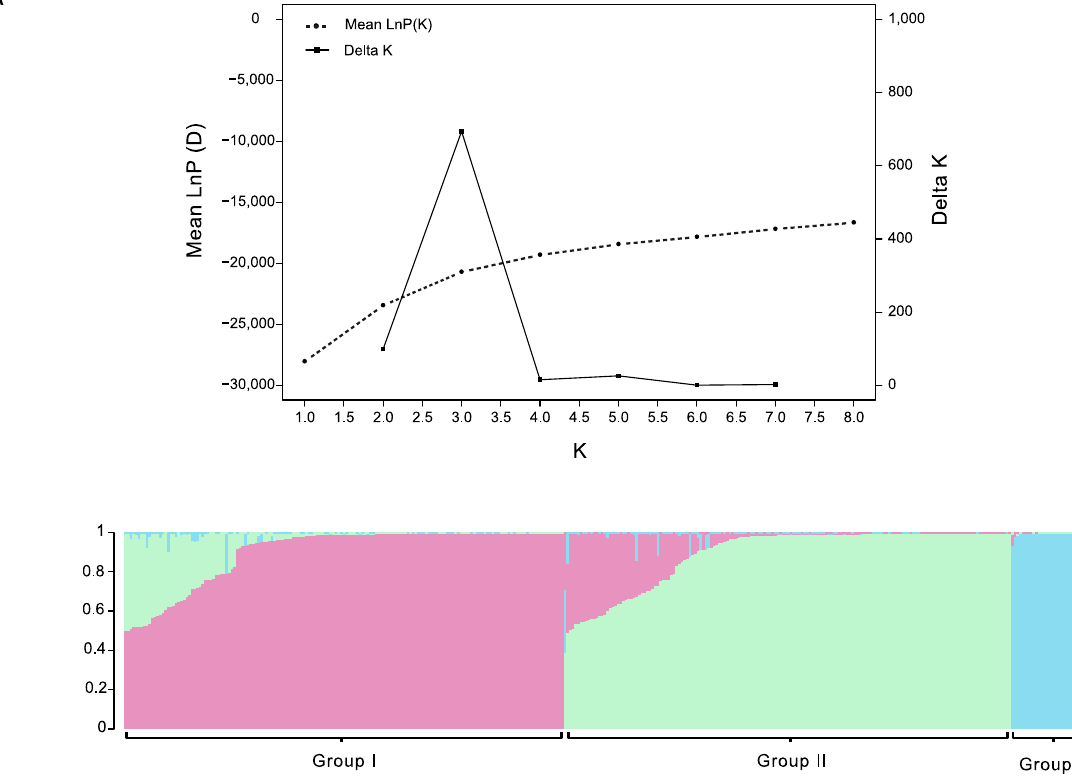
Figure 3. The population structure of 365 rice accessions at K= 3. ( A ) The average log-likelihood of the K-value against the number of K and delta K for different numbers of subpopulations (K); ( B ) the estimated population structure of the 365 Thai landrace accessions on K = 3.